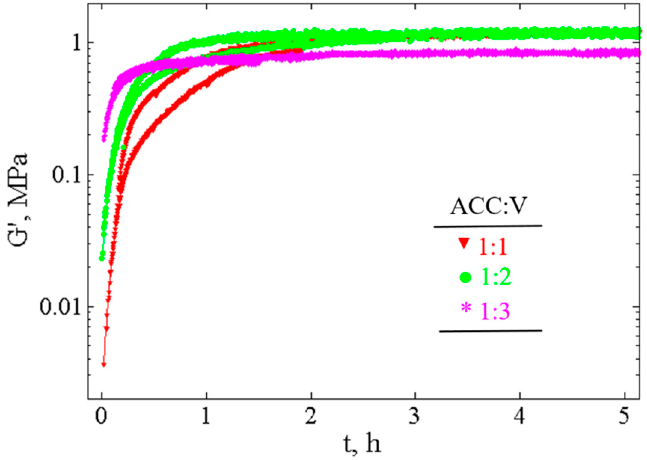
Figure 4. Time evolution of storage modulus, G’, for three different CaCO 3 cement compositions